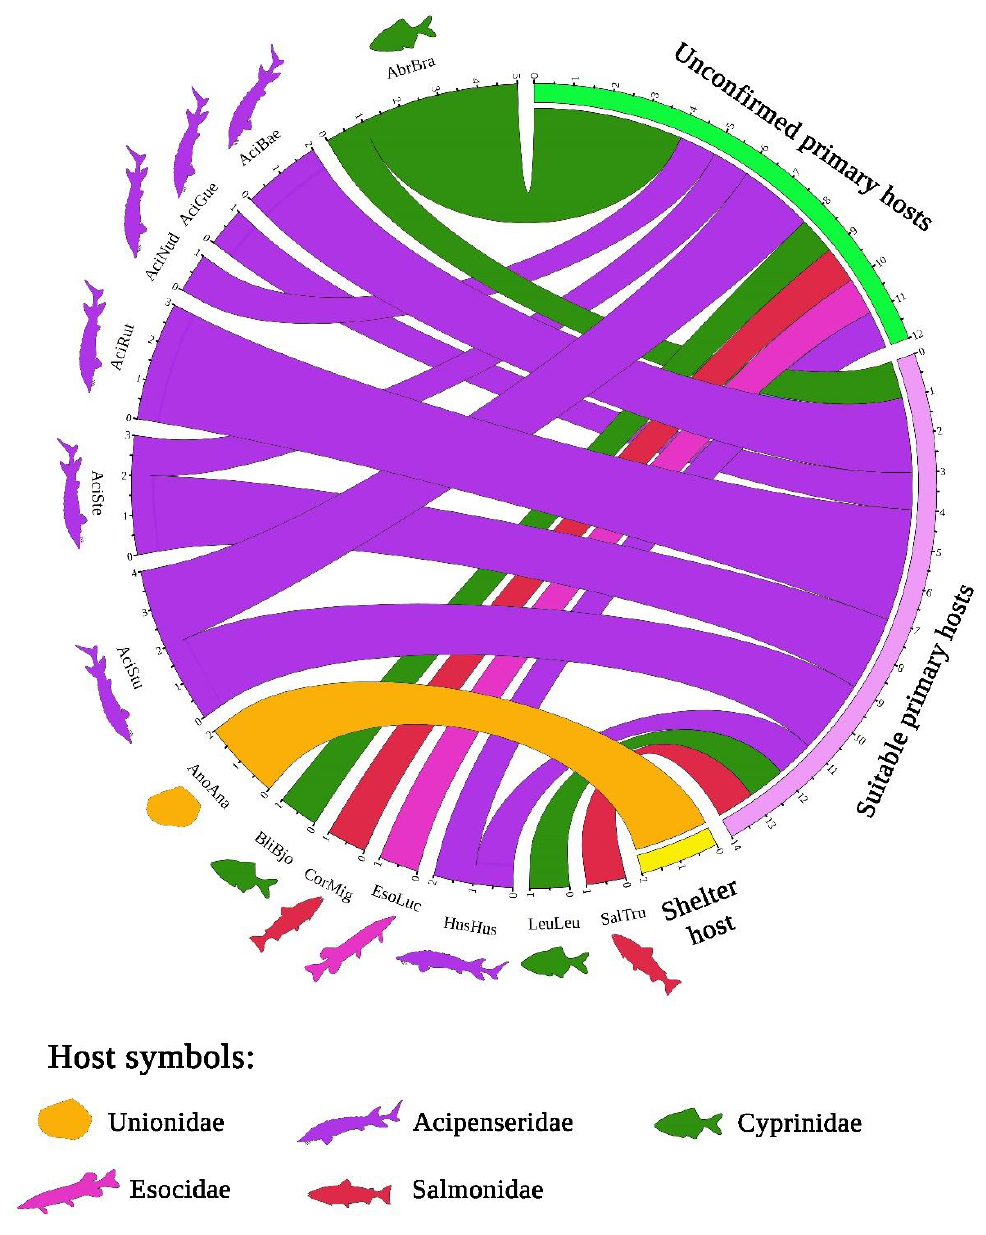
Figure 5. Circos plot of Acipenserobdella volgensis (Zykoff, 1904) host range based on the raw host records. Groups of hosts are represented by arcs on the left half of the circle with a size determined by the total number of raw host records for each group (Table S2). Their colors refer to the group of hosts: shelter host (light yellow), suitable primary host (light purple), and unconfirmed primary host (light green). Linking lines between these groups represent shared hosts, with the thickness proportional to the number of available records of this host for each group. The line color refers to the host family: Acipenseridae (purple), Cyprinidae (green), Salmonidae (red), Esocidae (pink), and Unionidae (yellow). Host name abbreviations: AnoAna, Anodonta anatina ; AciBae, Acipenser baerii ; AciGue, Acipenser gueldenstaedtii ; AciNud, Acipenser nudiventris ; AciRut, Acipenser ruthenus ; AciSte, Acipenser stellatus ; AciStu, Acipenser sturio ; HusHus, Huso huso ; AbrBra, Abramis brama ; LeuLeu, Leuciscus leuciscus ; BliBjo, Blicca bjoerkna ; CorMig, Coregonus migratorius ; SalTru, Salmo trutta ; and EsoLuc, Esox lucius . The plot was created with the online application of Circos software (http://mkweb.bcgsc.ca/tablevieweraccessed on 19 August 2022). Conversely, four fish species could be ranked as unconfirmed primary hosts: Acipenser nudiventris Lovetsky, 1828 (Acipenseridae); Blicca bjoerkna (Linnaeus, 1758)